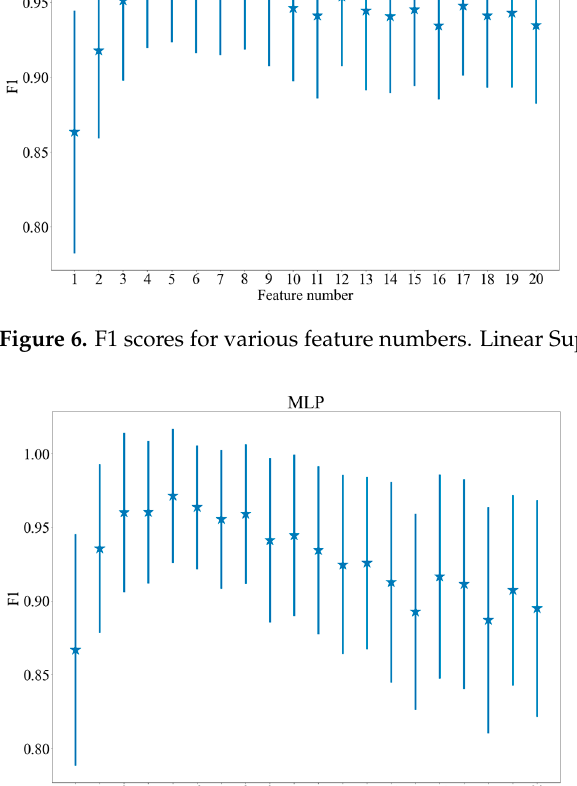
Table 6. Mean confusion matrix for Logistic Regression classifier with linear